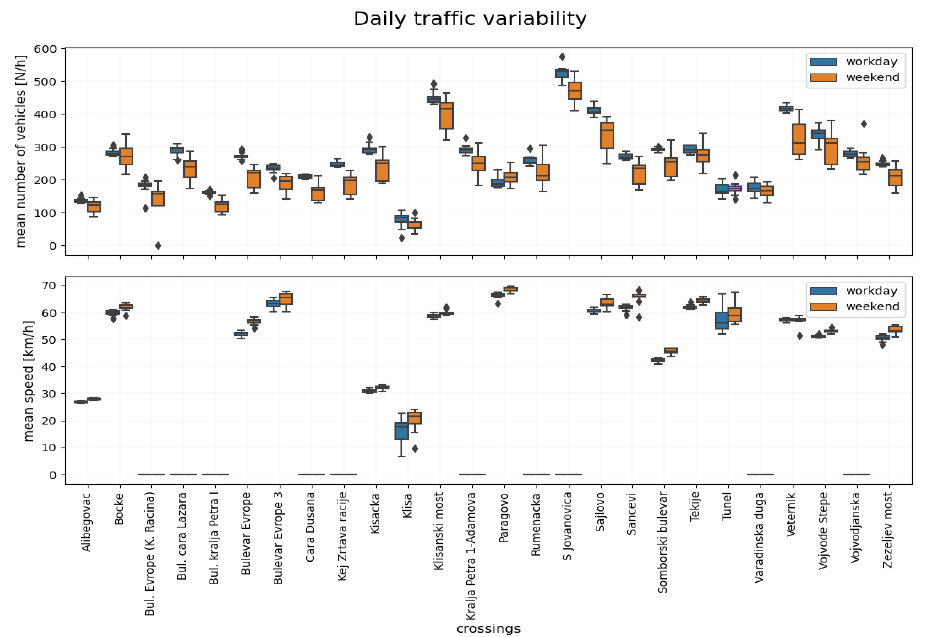
Figure 5. On the first subplot, the variability of the daily number of vehicles is shown, while on the second plot, the variability of average speed on a daily level is presented. The dashes in the second subplot present counters with no speed